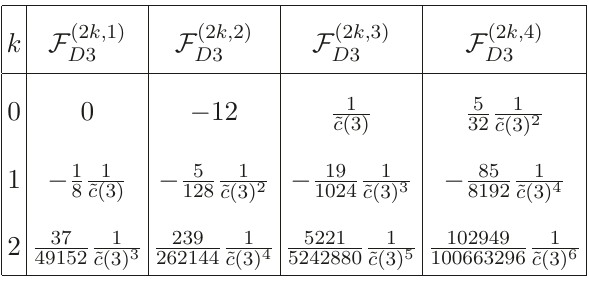
Table 4 . The coefficients of the dual prepotential for the N f = 3 theory, where ˜ c (3) = i 2 − 13 / 2 [32].